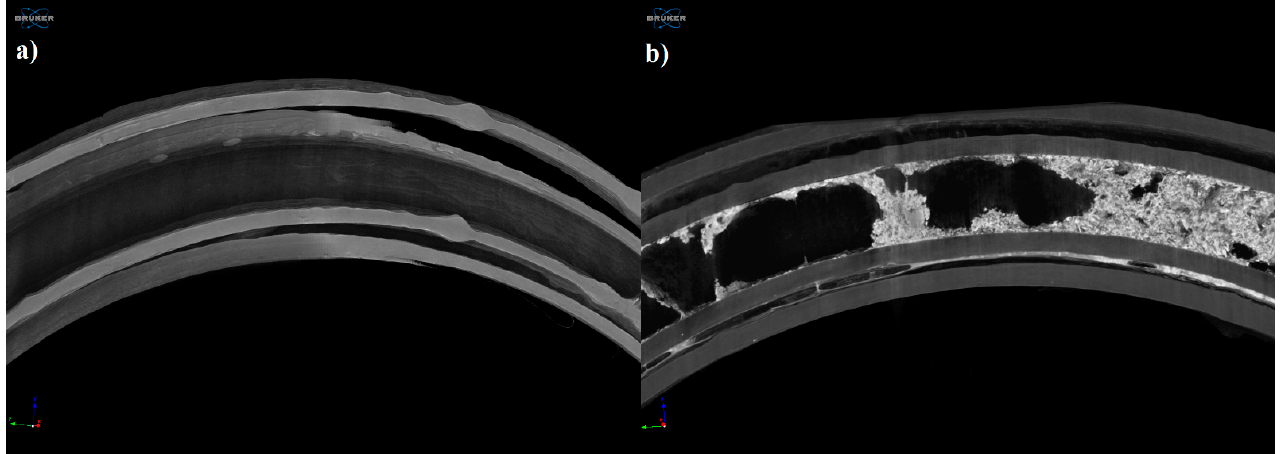
Figure 7. Reconstructed microCT image from a vertical cut of the printed sample ( a ) and examined sample after the dissolution test ( b ). Image pixel size is 5 μ m.